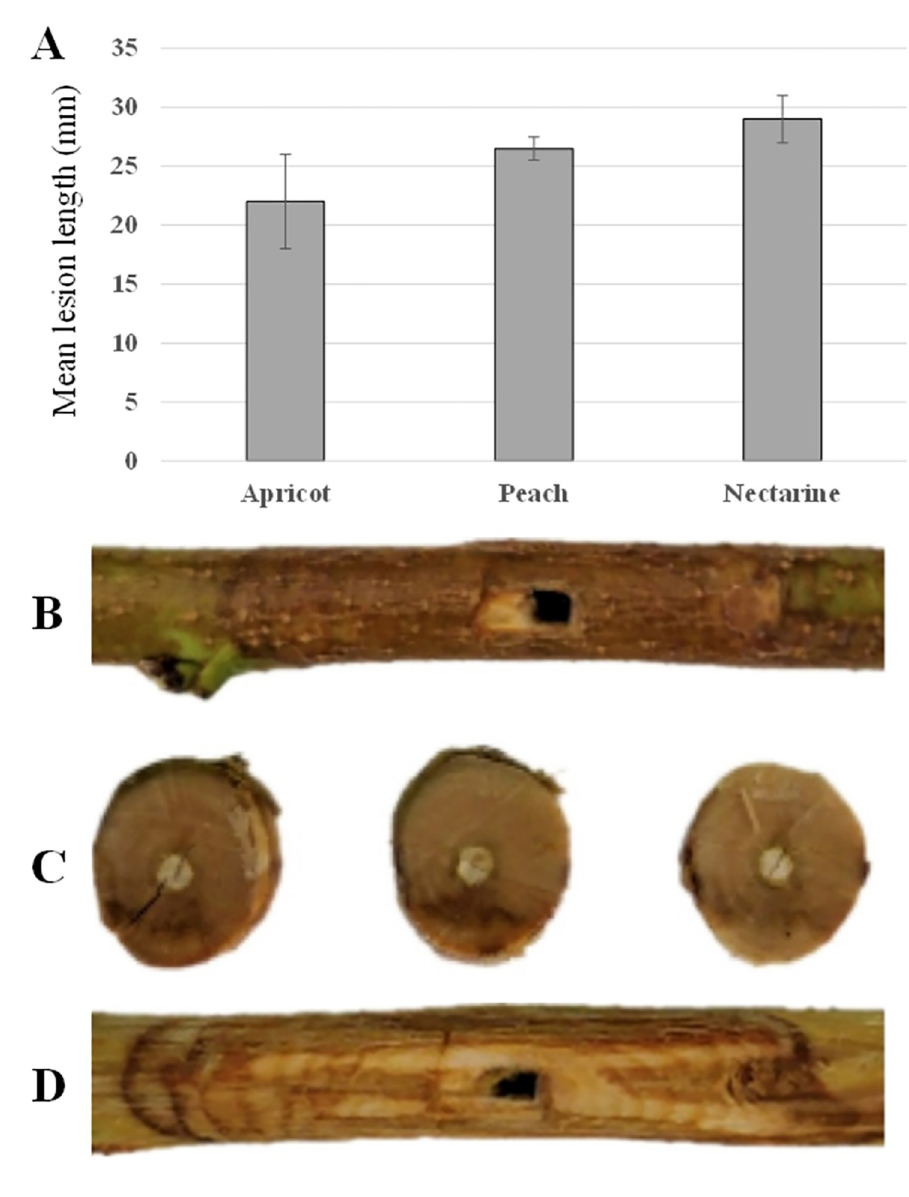
Fig 5. A. Mean lesion length caused by C . paraplurivora in Prunus spp. 12 days post-inoculation. B-D. Symptoms caused by C . paraplurivora (FDS-564) in excised branches of P . persica var. nucipercica 12 days